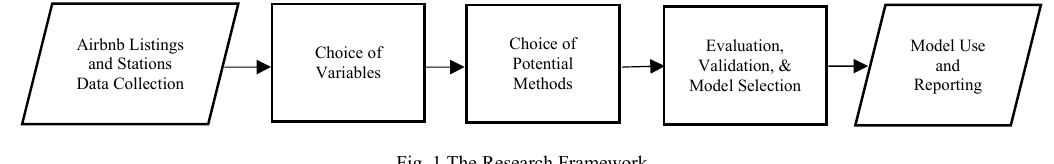
Fig. 1 The Research Framework